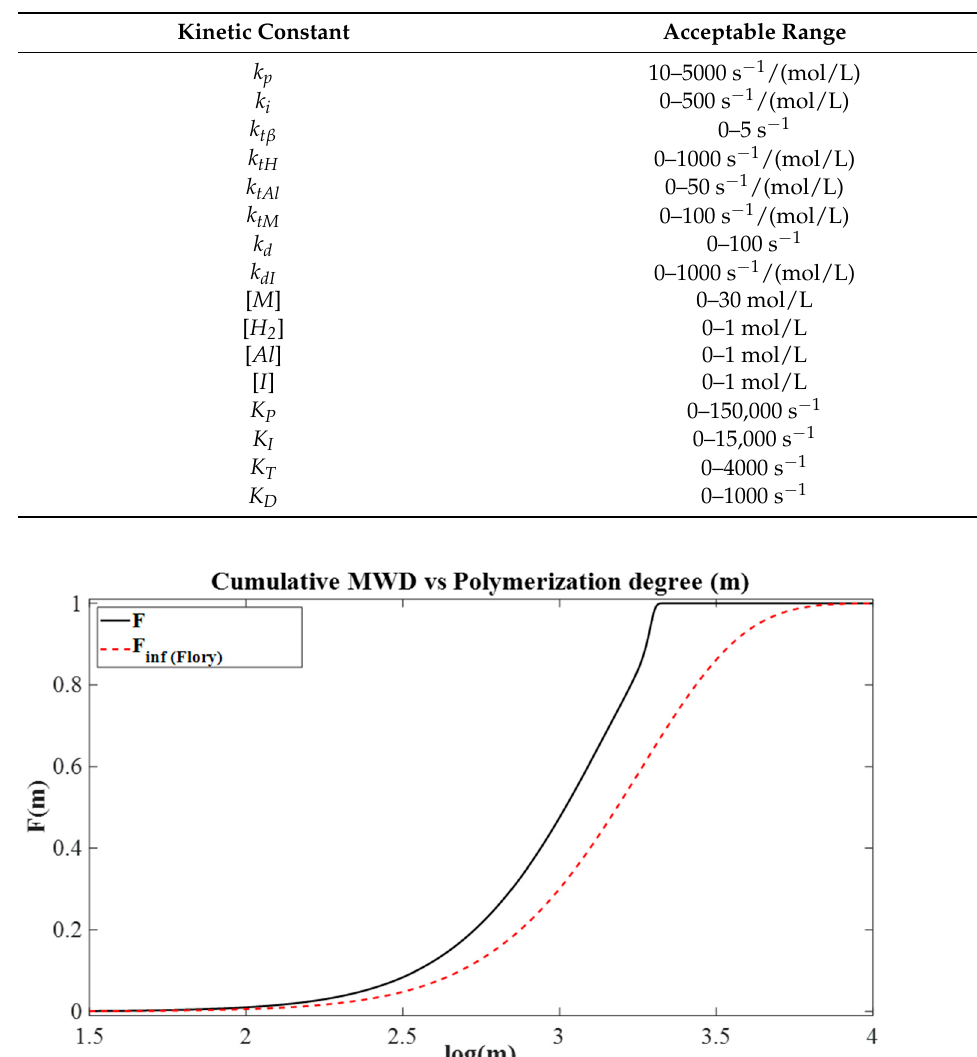
Table 1. Normal Range of Kinetic Constants.